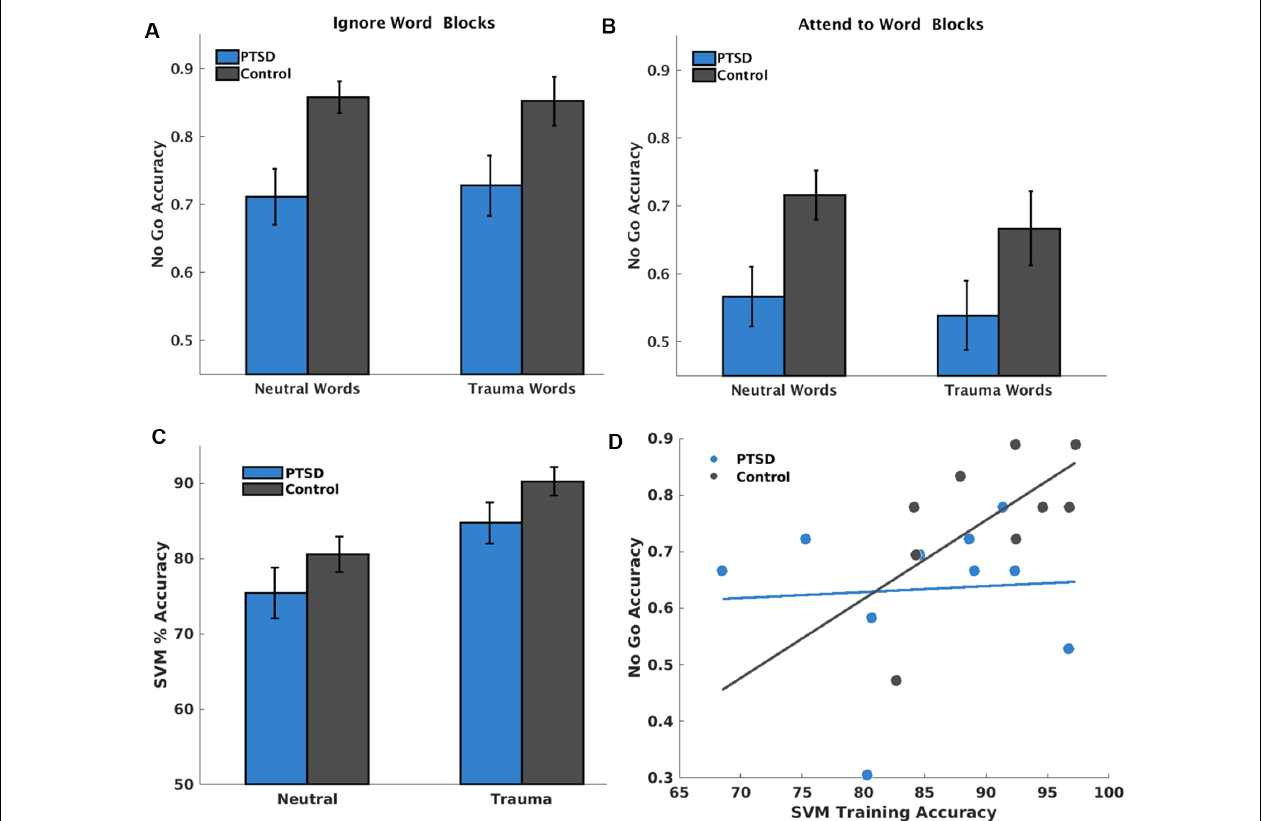
FIGURE 2 | Behavioral performance and classifier accuracy during training runs. (A) Mean No Go accuracy on blocks where participants were instructed to ignore the words (i.e., attend to faces), separated by whether the block included trauma or neutral words. (B) The same as (A) except for blocks where participants were instructed to attend to the words. (C) Group differences in support vector machine (SVM) classifier accuracy during training runs in attend-to-word and attend-to-face blocks dependent on the presence of trauma-related words. Results showed significantly poorer classifier accuracy during neutral word blocks for both posttraumatic stress disorder (PTSD) and control groups, but no overall group differences on classifier accuracy. (D) Scatterplot depicting the significant linear relationship between mean SVM cross-validation accuracy and mean no go accuracy, suggesting that better brain state differentiation is related to better attention towards task-relevant